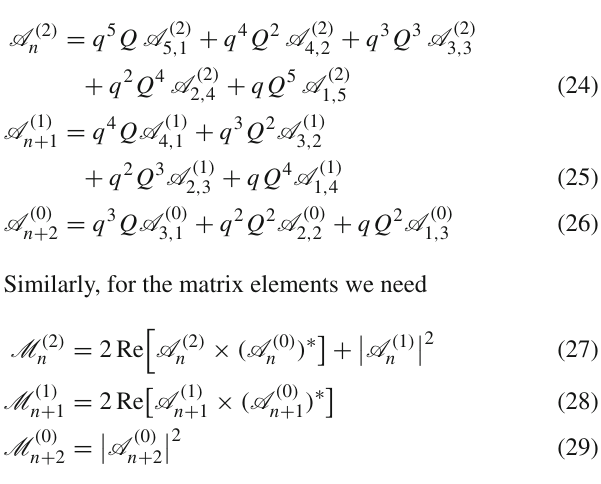
( 1 ) (rr), M n + 2 n + 1 l Q 8 − l with l ∈